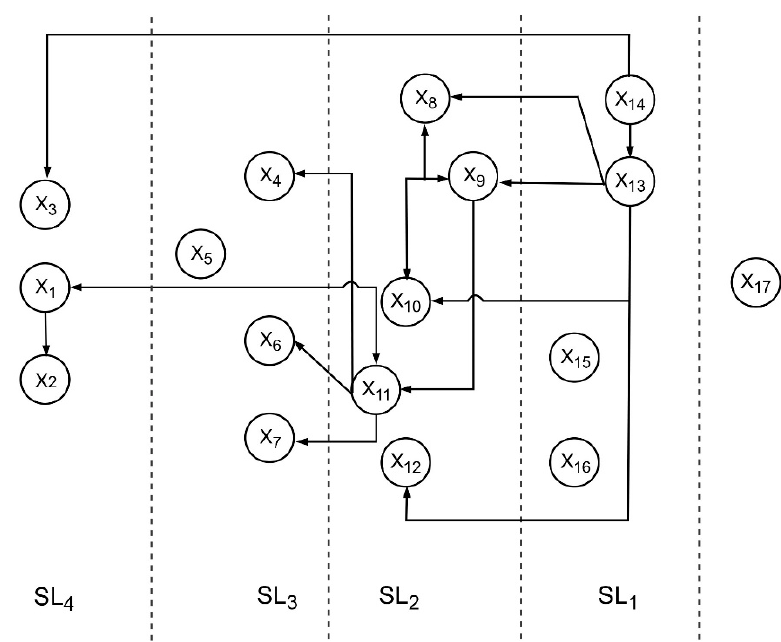
Figure 6. Path and trace representation of the causal in marine traffic accident network.